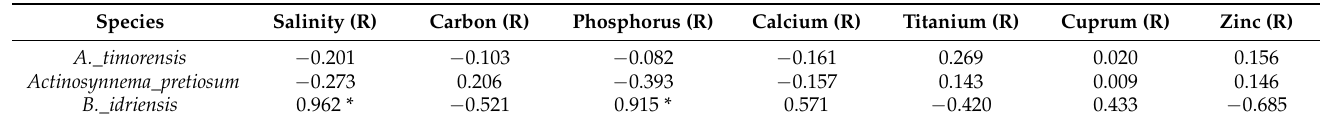
Table 3. Correlation between Bacterial Abundance Associated with the Root of C. gigantea and Soil Properties.